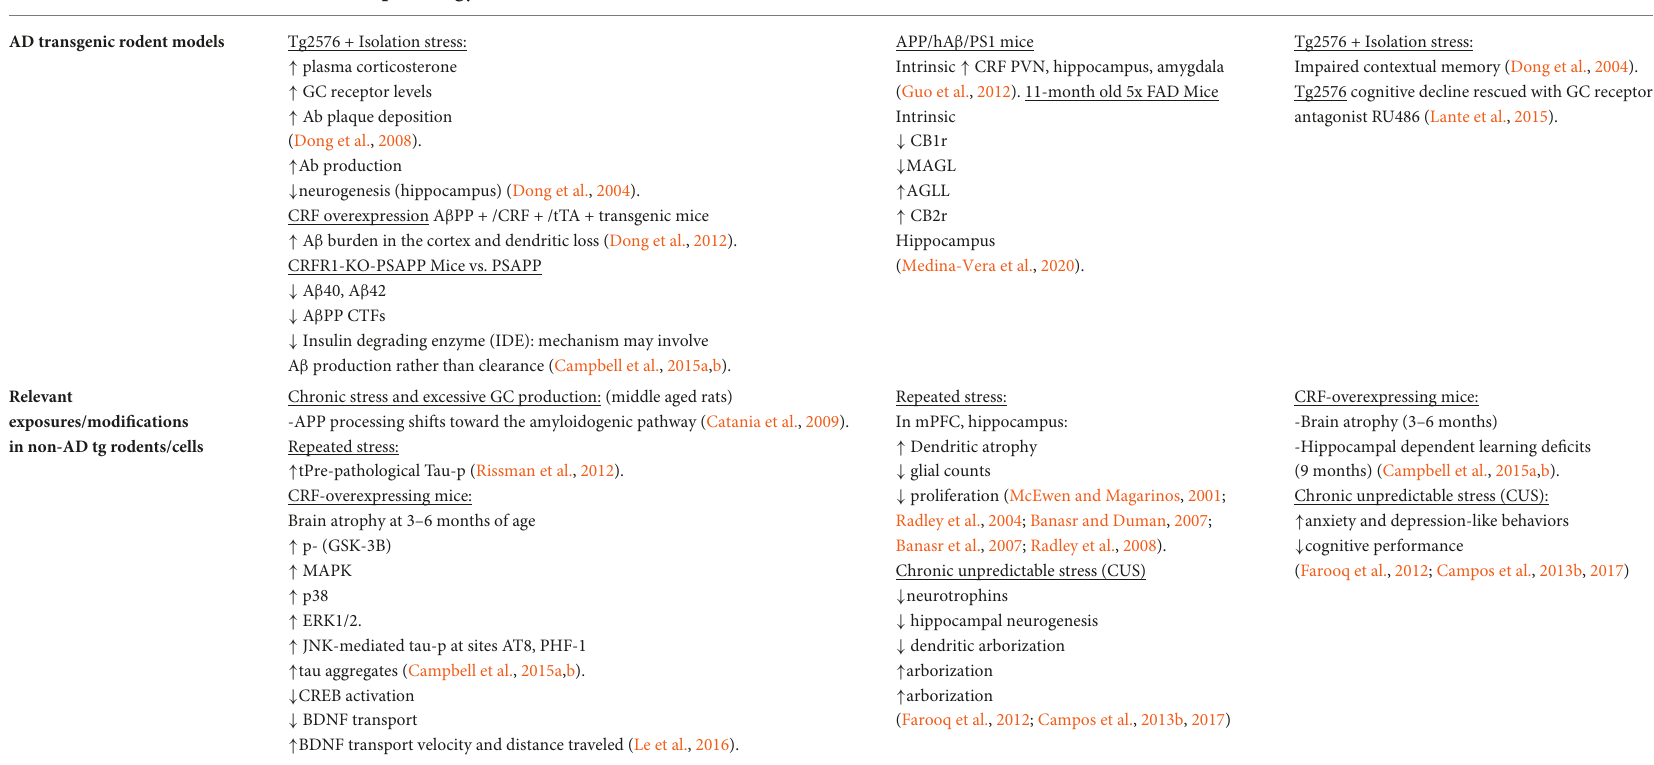
TABLE 1 Influence of stress/stress